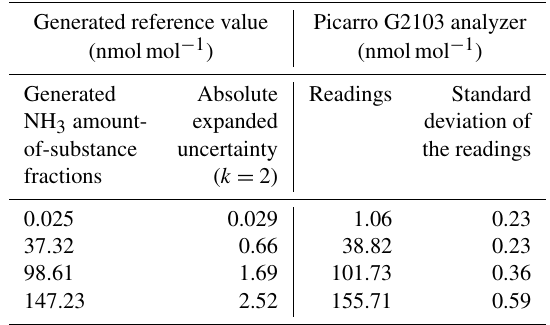
Table 8. The results of the Picarro G2103 analyzer calibration per- formed by METAS. The generated amount-of-substance fractions and reading values are the average of the last 30min of the gener- ation and reading, respectively. The coverage factor ( k ) of the ex- panded uncertainty of the generation is indicated.